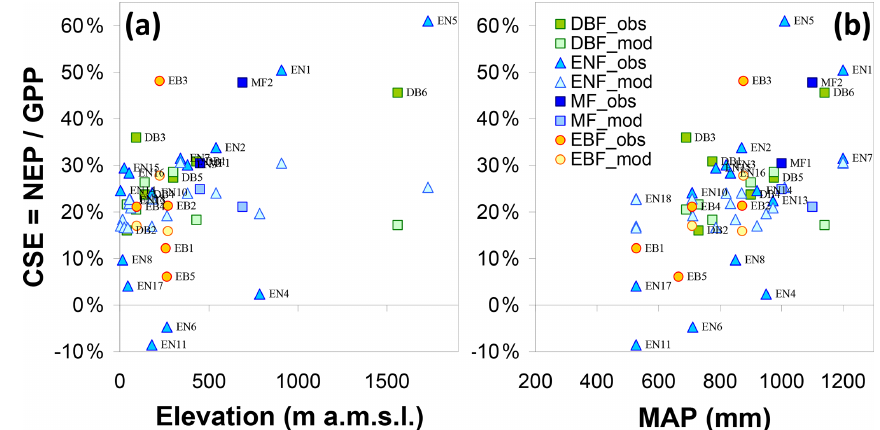
Figure 8. Variability of observation-based and modelled carbon sequestration efficiency (CSE, defined as the NEP / GPP ratio), as a function of (a) site elevation above mean sea level (m), and (b) MAP: mean annual precipitation (mm). Site labels are provided for observations